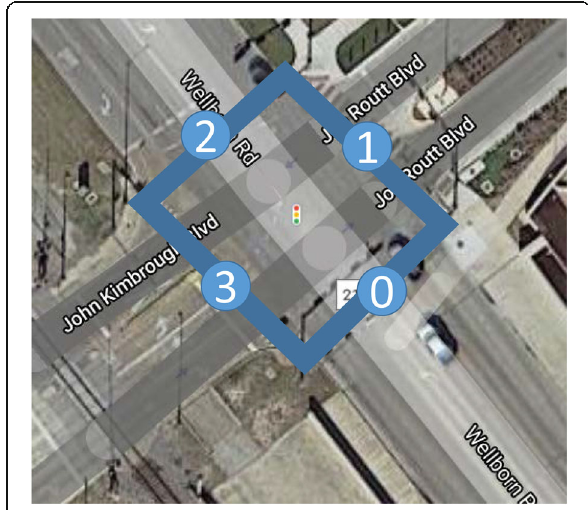
Fig. 9 Definition of intersection polygons at the intersection of Wellborn Road and Kimbrough